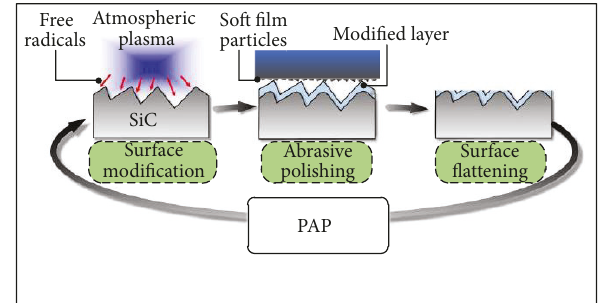
Figure 18: Plasma-assisted polishing principle